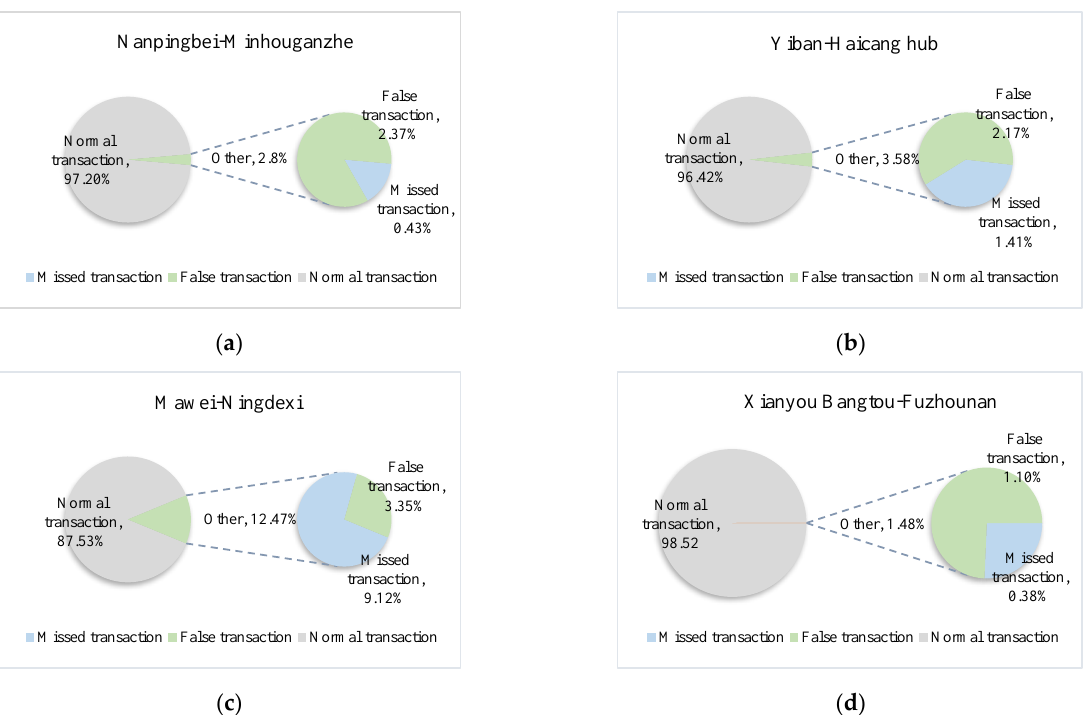
Figure 11. Abnormal transaction ratios of the driving trajectories. ( a ) The abnormal proportions of missed transactions and false transactions in Nanpingbei-Minhou Ganzhe are 0.43% and 2.37%; ( b ) The abnormal proportions of missed transactions and false transactions in Yi-ban-Haicang hub